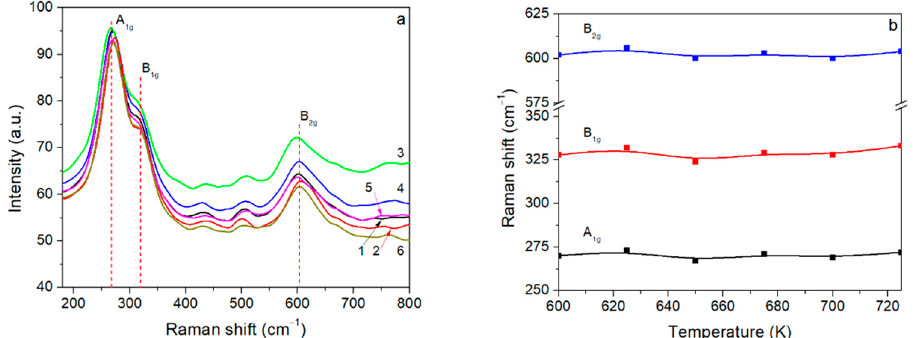
Figure 5. ( a ) Raman spectra of CuO films obtained at different temperatures and ( b ) peaks shift of the films, T s , K: (1) 600, (2) 625, (3) 650, (4) 675, (5) 700, (6)